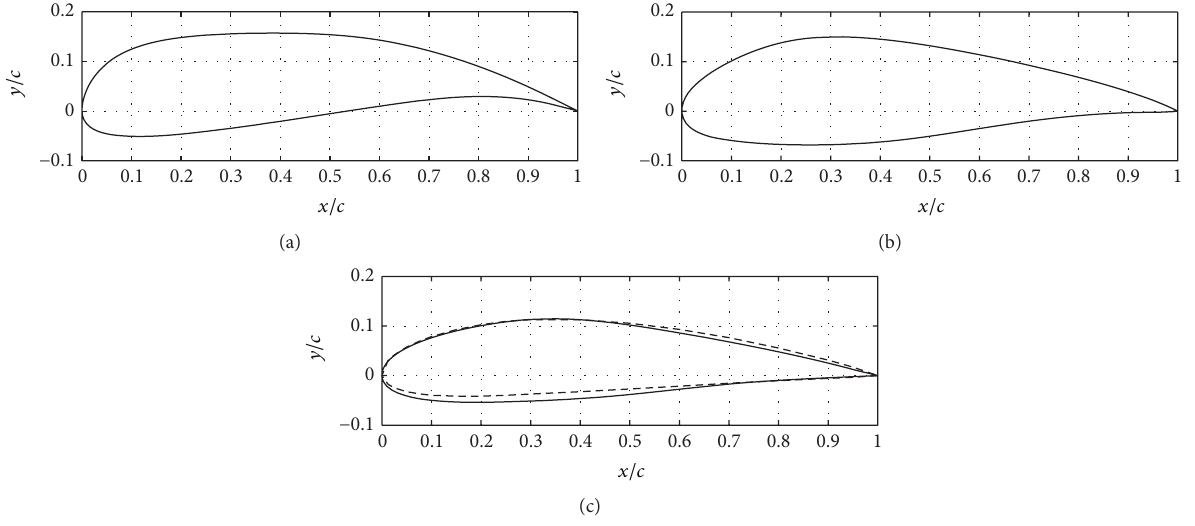
Figure 2: Measured blade airfoil coordinates: (a) root; (b) midsection; (c) tip with NACA 4415 airfoil (dashed line).